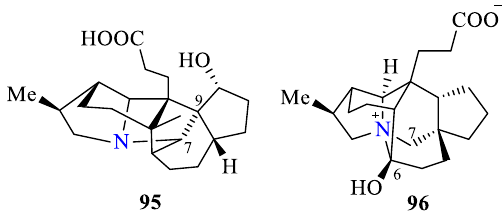
11 of 23 Figure 3. The examples of Daphniphyllum alkaloids. Out of the Daphniphyllum alkaloid family, special mention should be made of the group of compounds with a non-classical structure [50,51]. This group includes, in partic- ular, longeracemine 95 and angustimine 96 (Figure 4). A specific feature of longeracemine